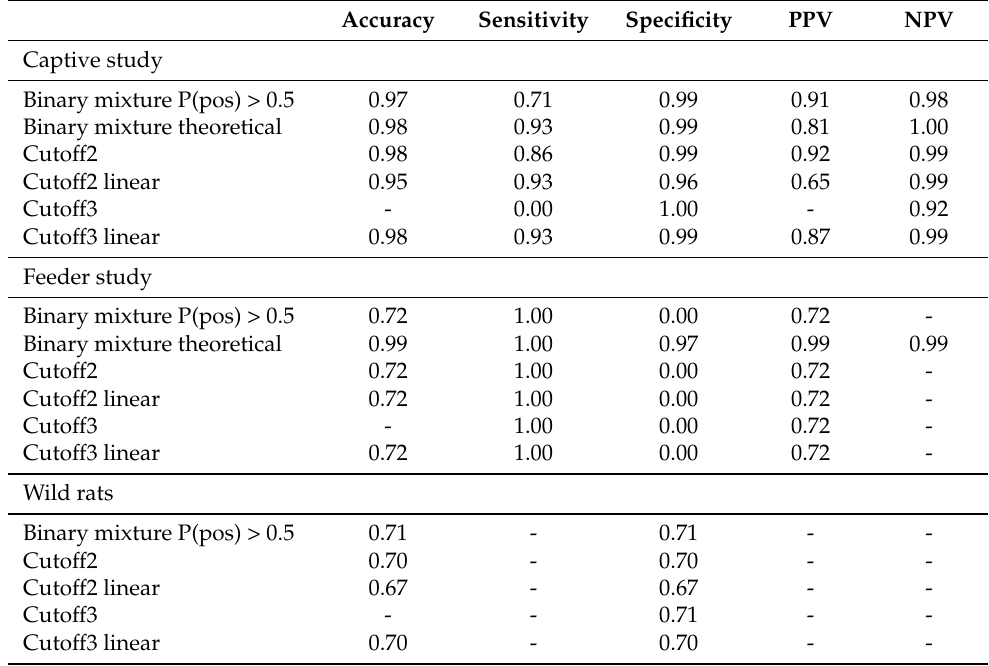
Table 3. Accuracy measures compared between the binary mixture model and the four cut-off choices (mean plus 2 × SD, or 3 × SD, each in both linear and log10 scale) with RT-qPCR. For the binary mixture model classification, the positivity of the rats was determined using the probability of positivity Pr ( pos | x ) > 0.5. In some situations, the measures are not defined, e.g., in the captive rat study for cut-off values of the mean plus three standard deviations, the positive predictive value is not defined, since all rats were predicted negative. The theoretical binary mixture accuracy measures were not shown for the wild rat population, since they are not relevant for an all-negative